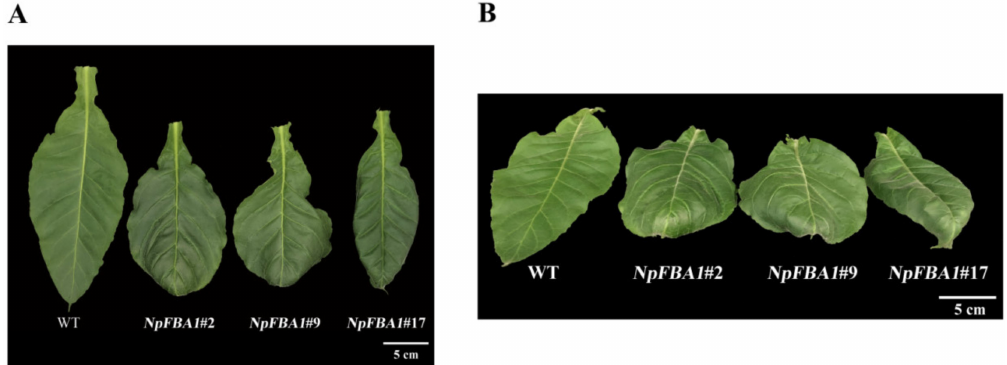
Figure 5. Effects of NpFBA1 on leaf morphology. ( A , B ) WT and transgenic plant leaf morphology.